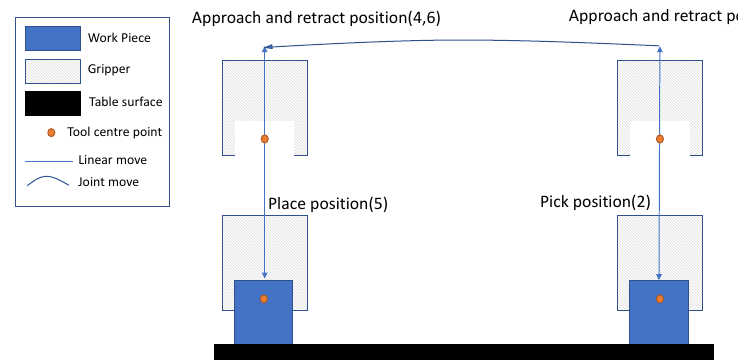
Figure 7. Program cycle of industrial robots pick and place task.